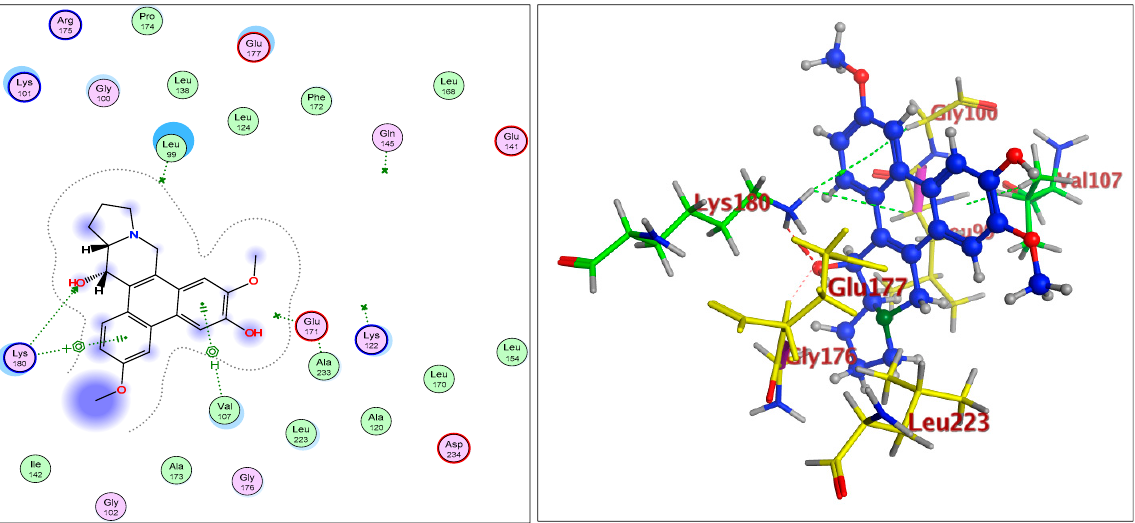
Figure 4. Overlay of compound ( 3 ) bound to the active site of ATP-binding pocket of Aurora-B.